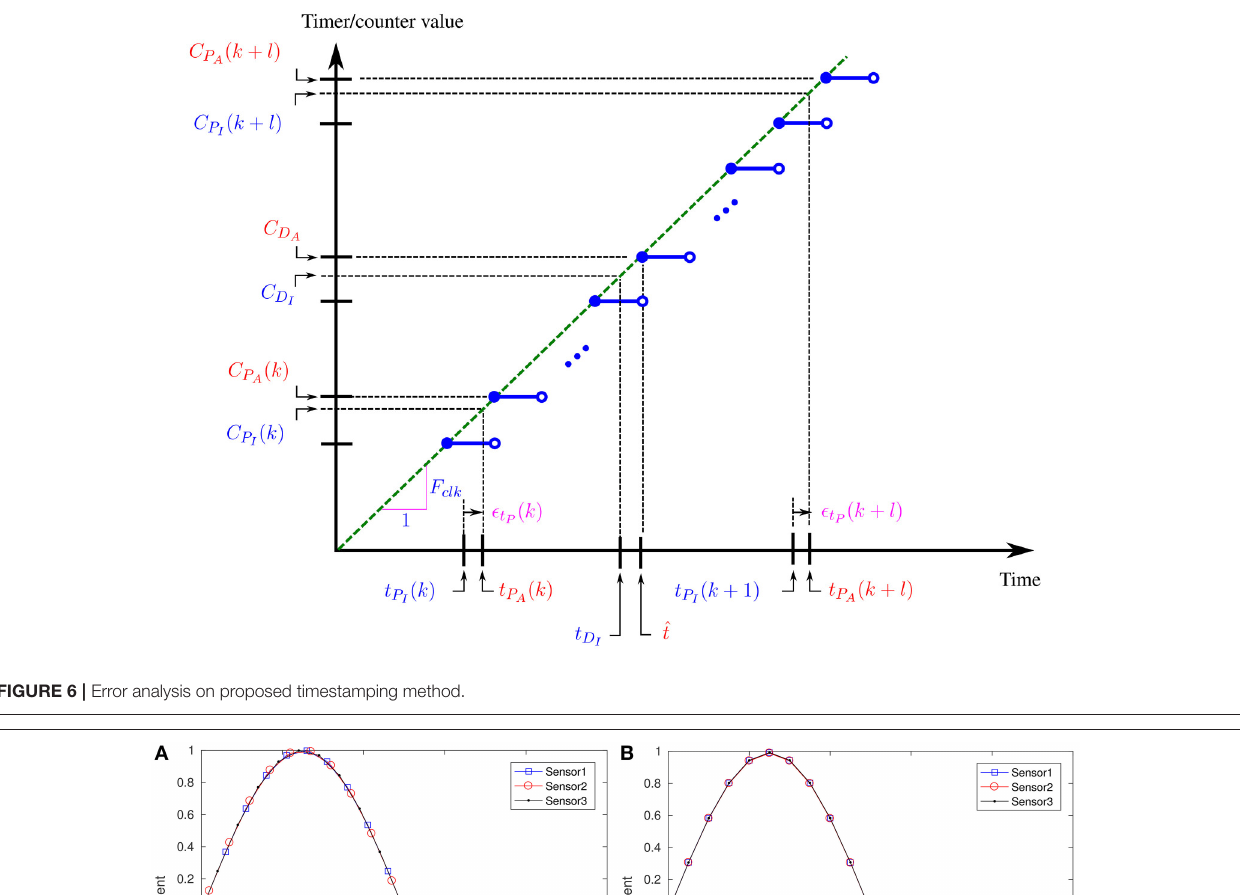
FIGURE 6 | Error analysis on proposed timestamping method.